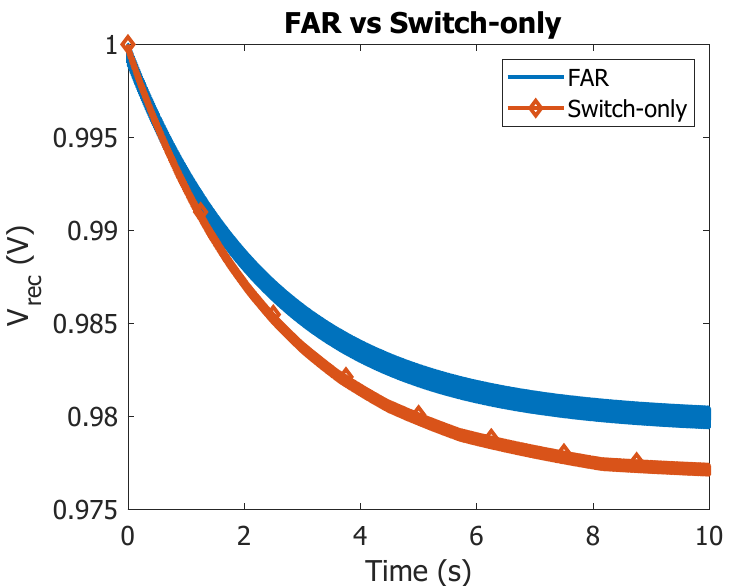
Figure 9. Simulated transient evolution of V rec in FAR and Switch-only when R L = 48k Ω , with 1V initial condition.